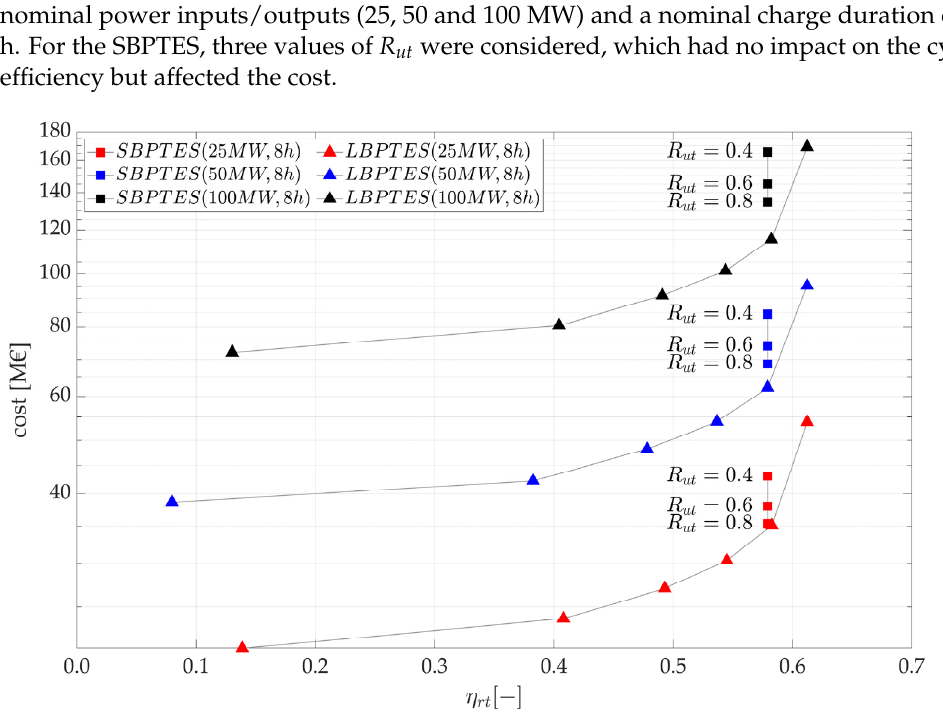
Figure 7. Comparison between the roundtrip efficiency and cost in MEUR achieved by LBPTES and SBPTES systems. The results are reported for three values of nominal power rating (25, 50 and 100 MW) and refer to a nominal charge duration of 8 h. For SBPTES, the capacity utilisation ratios ( R ut ) equal to 0.4, 0.6 and 0.8 are reported.